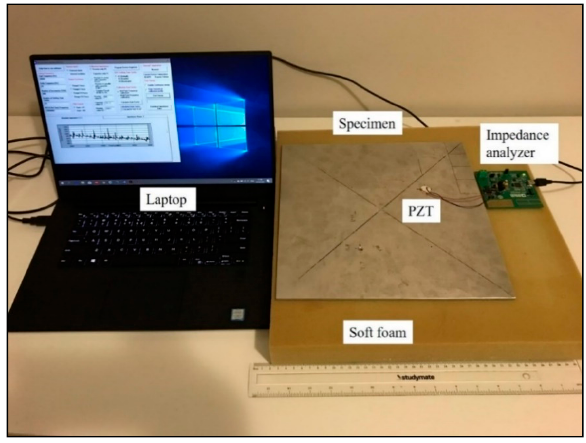
Figure 4. Configuration of the experimental test